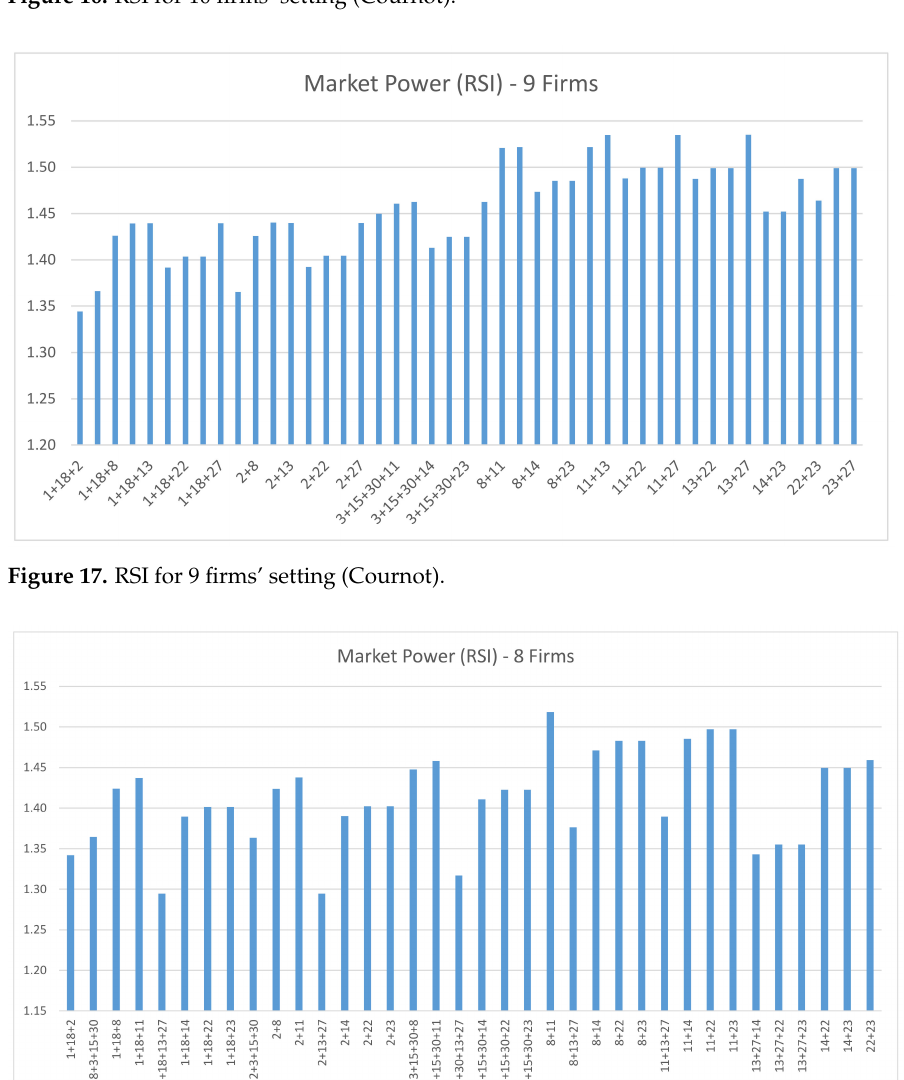
Figure 16. RSI for 10 firms’ setting (Cournot).